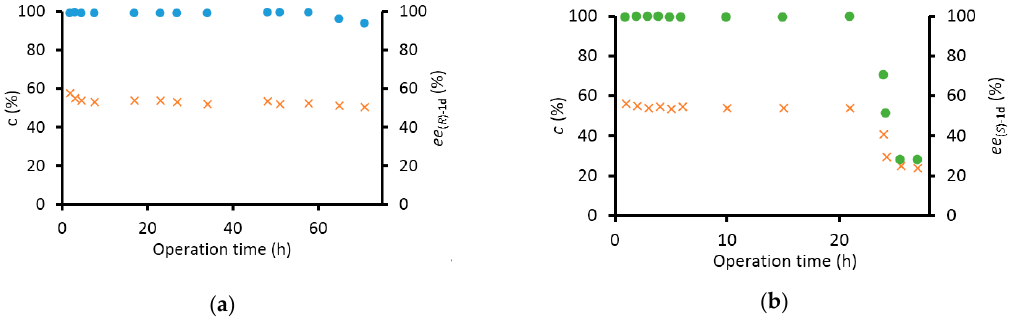
Figure 2. Long-term stability of the most efficient ( S )-selective ( Ar S-TA) and ( R )-selective ( AtR -TA) immobilized TA biocatalysts in preparative scale continuous-flow kinetic resolution of rac - 1d with ( a ) immobilized Ar S-TA; and ( b ) immobilized AtR -TA [conversion ( × ), ee ( R )- 1d ( ● ) and ee ( S )- 1d ( ●